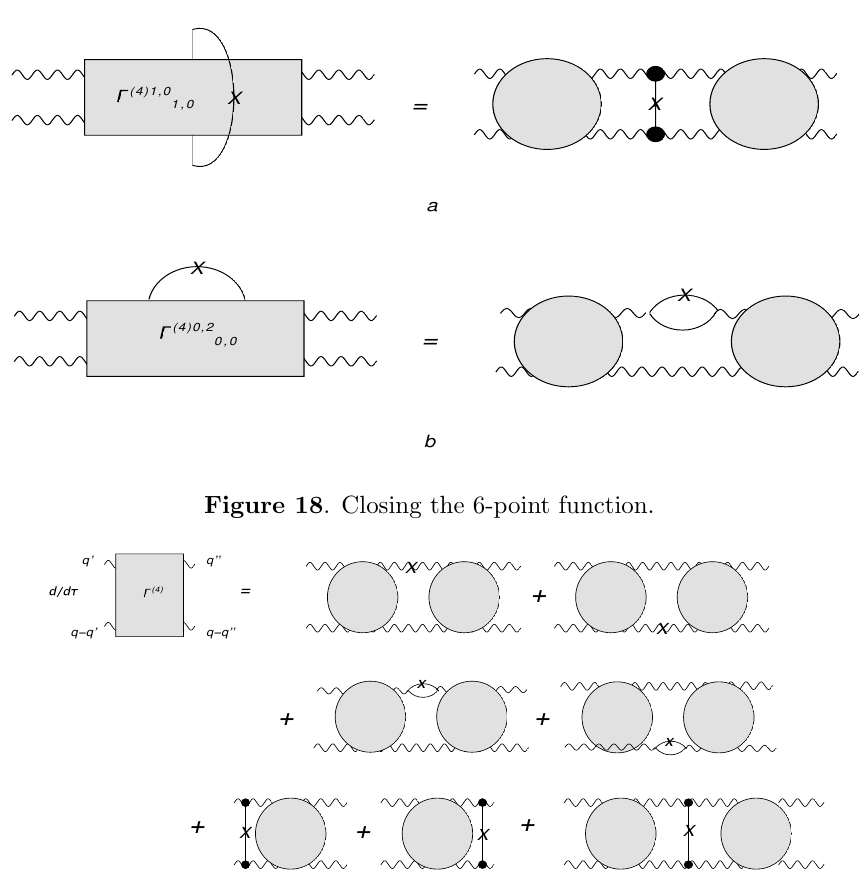
Figure 19 . Modi(cid:12)cation of (cid:13)ow equation in (cid:12)gure